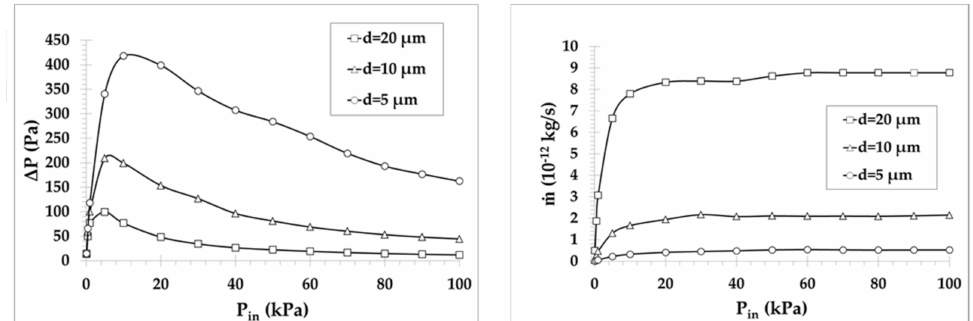
Figure 5. ( a ) Pressure di ff erence and ( b ) mass flow rate versus inlet pressure for the one-stage pump A with d = 5,10,20 µ m (mass flow rates are given for a single channel of the pump). The rarefaction parameter is ranging from 0.03 to 130, and it increases with the inlet pressure and the diameter, providing the maximum pressure di ff erence at δ = 3 − 4, in the transition